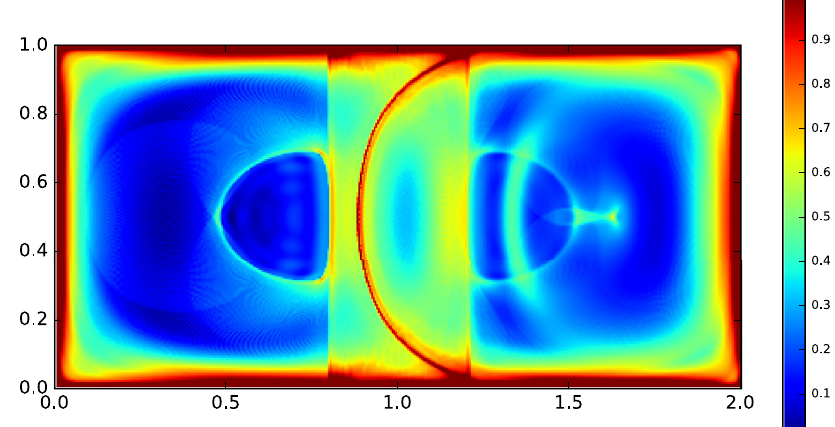
Fig. 4 Plot of Lagrangian betweenness for the double-gyre fl ow with a normalized logarithmic color map. Here, we performed a fi ne numerical integration (with N = 300) to converge to the analytical expression for Lagrangian betweenness of Eq. (5). Higher values of Lagrangian betweenness are found at the boundaries and across the narrow semicircular line splitting the domain vertically. The region spanned by the moving line separating both gyres is clearly highlighted by intermediate values of